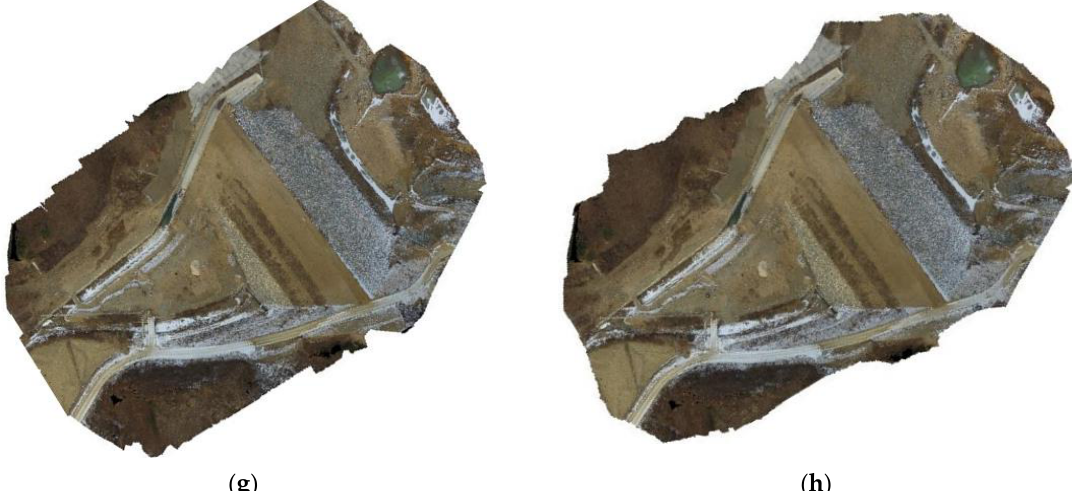
Figure 5. Orthophotos obtained using mesh construction and texturing with data acquired by the UAV: ( a ) case 1, ( b ) case 2, ( c ) case 3, ( d ) case 4, ( e ) case 5, ( f ) case 6, ( g ) case 7, and ( h ) case 8.